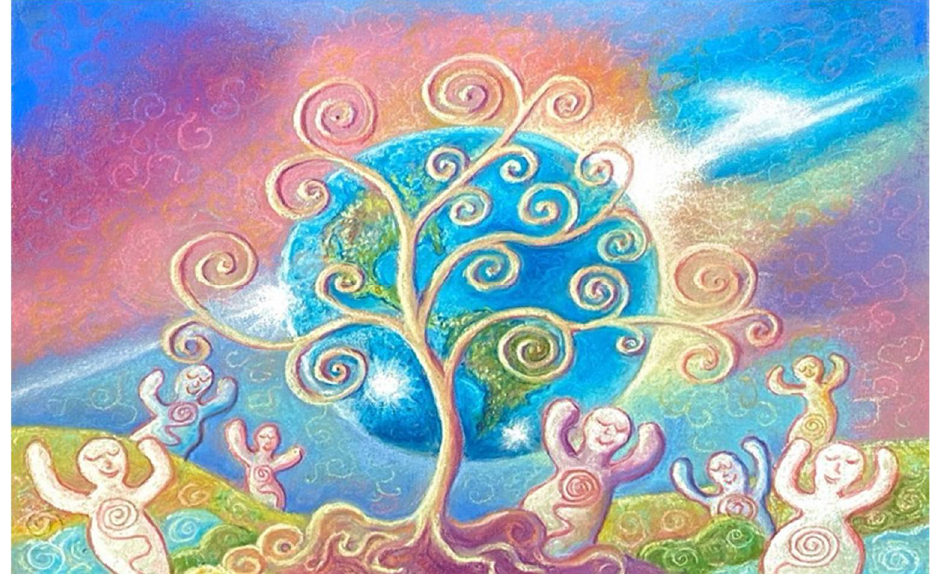
Figure 2. Planetary health depends on flourishing at all scales and is rooted in reciprocity and mutualism—valuing human life as inseparable from all life and working to sustainably align the interests of individuals, communities, and ecosystems (artwork by S.L.P.).